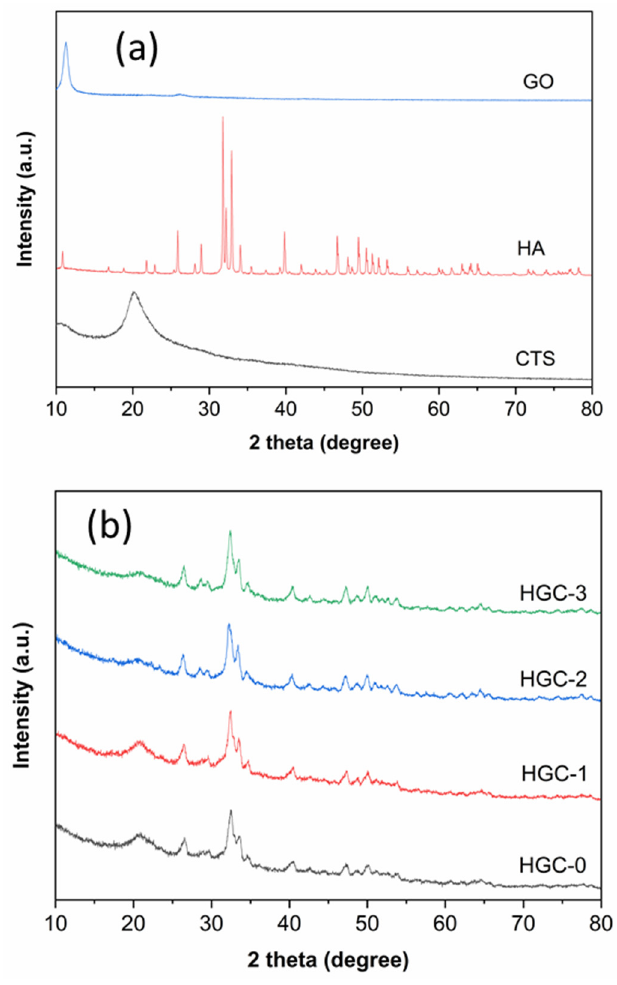
Figure 2. XRD patterns of ( a ) bare GO, pure HA, pure CTS, and ( b ) various HGC beads. The chemical structure of the samples was determined by FT-IR spectroscopy. Figure 3